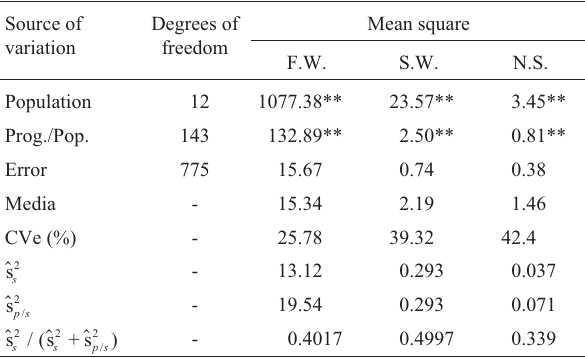
Table 3 - Analysis of variance and estimates of genetic parameters for the traits fruit weight (FW), seed weight (SW) and number of seeds